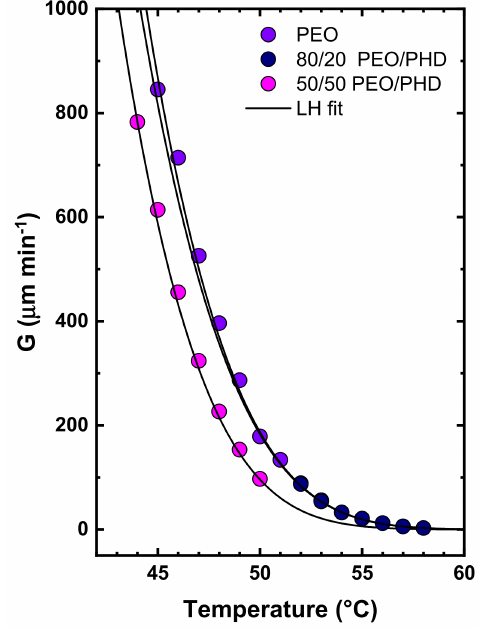
Figure 4. Spherulitic growth rate (G) as a function of isothermal crystallization temperature for neat PEO and for the PEO component of the 80/20 and 50/50 PEO/PHD